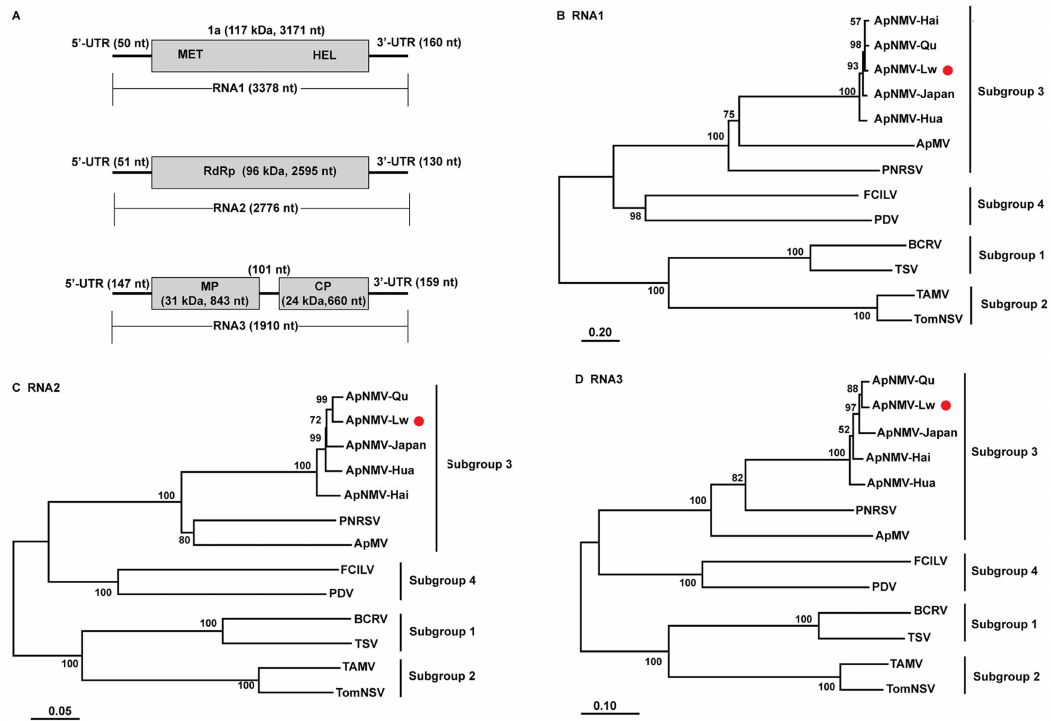
Figure 1. The genome organization of apple necrotic mosaic virus (ApNMV)–Laiwu isolate and its phylogenetic relationships with other members of Ilarvirus . ( A ) Genomic structure of ApNMV–Laiwu isolate. UTR, untranslated region; MET, methyltransferase; HEL, NTP-binding helicase; RdRp: RNA-dependent RNA polymerase; MP, movement protein; CP, coat protein. The phylogenetic trees of B – D were constructed using the neighbor-joining method based on the nucleotide sequences of RNA1, RNA2, and RNA3 of the ApNMV–Laiwu isolate (labeled by red spot) and other Ilarviruses , respectively. The blackberry chlorotic ringspot virus (BCRV, NC011553, NC011554, NC011555),